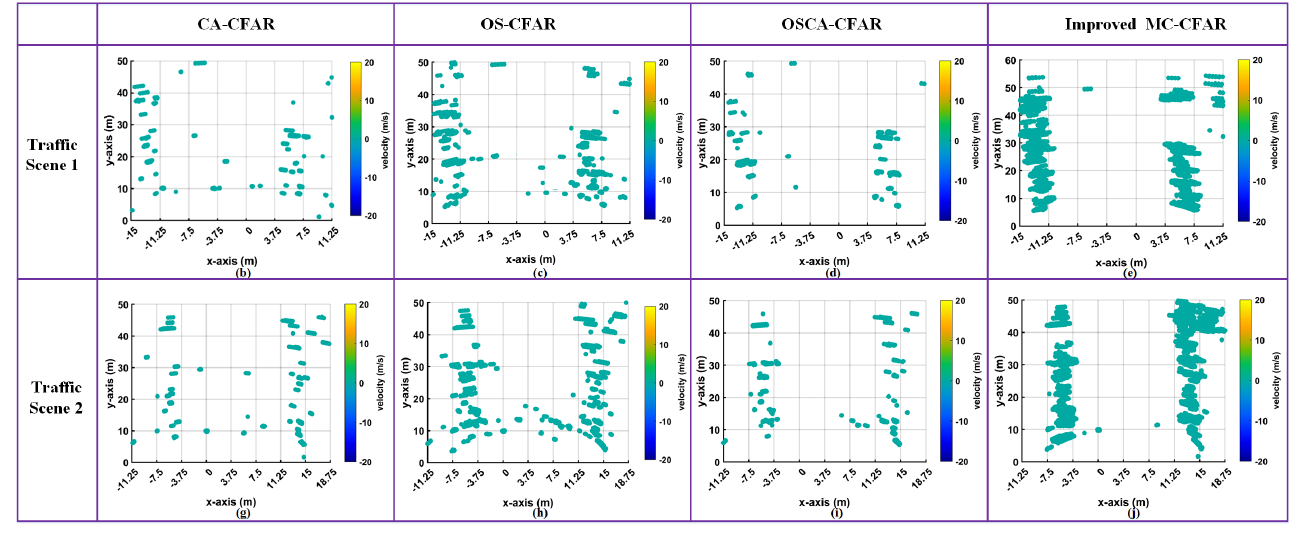
Figure 24. Static target imaging test.